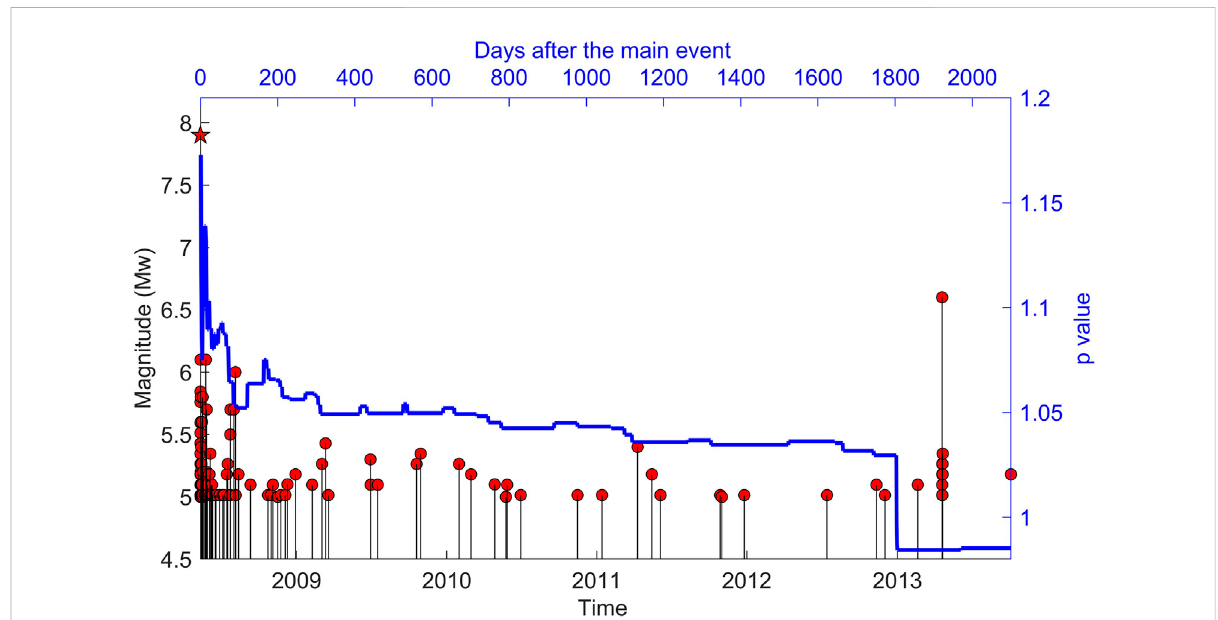
ThecumulativenumberofMw ≥ 5aftershocksobservedandpredicted.Theredlineshowsthecumulativenumberofobservedearthquakesand the blue dashed line shows the aftershocks predicted using the modi fi ed Omori Law using the aftershock data of the fi rst 100 days. The p, c and k values obtained from the fi rst 100 days of aftershock data of Mw ≥ 5 are shown in the fi